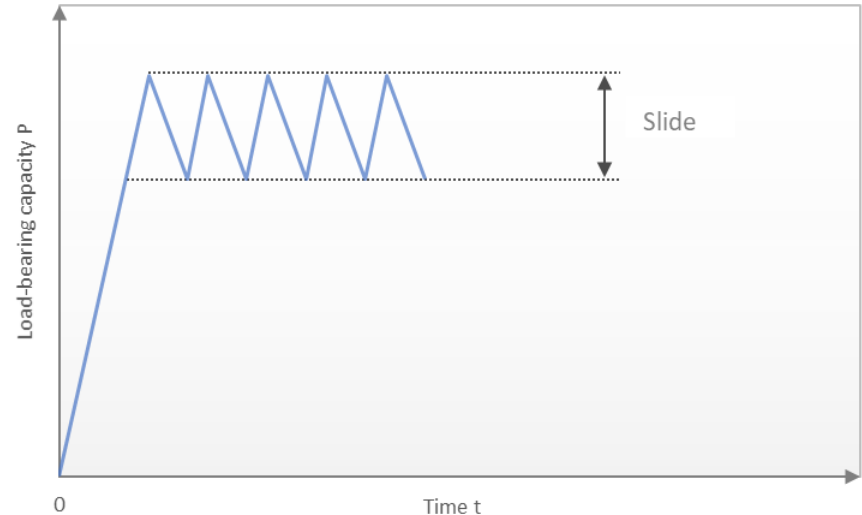
Figure 11. Roadway support lock operation [24].